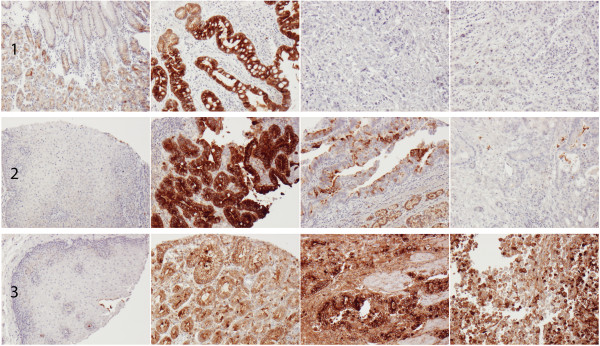
Sample immunohistochemical images of PIGR staining. Images (10× magnification) of PIGR expression in different tissue entities from three cases. The mean score corresponds to the value of the sum of the fraction × intensity of all annotated cores. From left to right: (1) normal gastric mucosa (mean/total score 0.70), intestinal metaplasia (mean/total score 3), primary tumour (mean/total score 0.2) and metastasis (mean/total score 0) in a T3N3M1 gastric cancer, (2) squamous epithelium (mean/total score 0), Barrett’s esophagus (mean/total score 3), two cores from primary tumour (score 2 and 0.2, respectively, mean/total score 1.1) in a T2N2M0 esophageal cancer, (3) squamous epithelium (mean/total score 0), normal gastric mucosa (mean/total score 2.0), and two cores from primary tumour (both score 3, mean/total score 3) from a T3N3M0 GE-junction cancer.